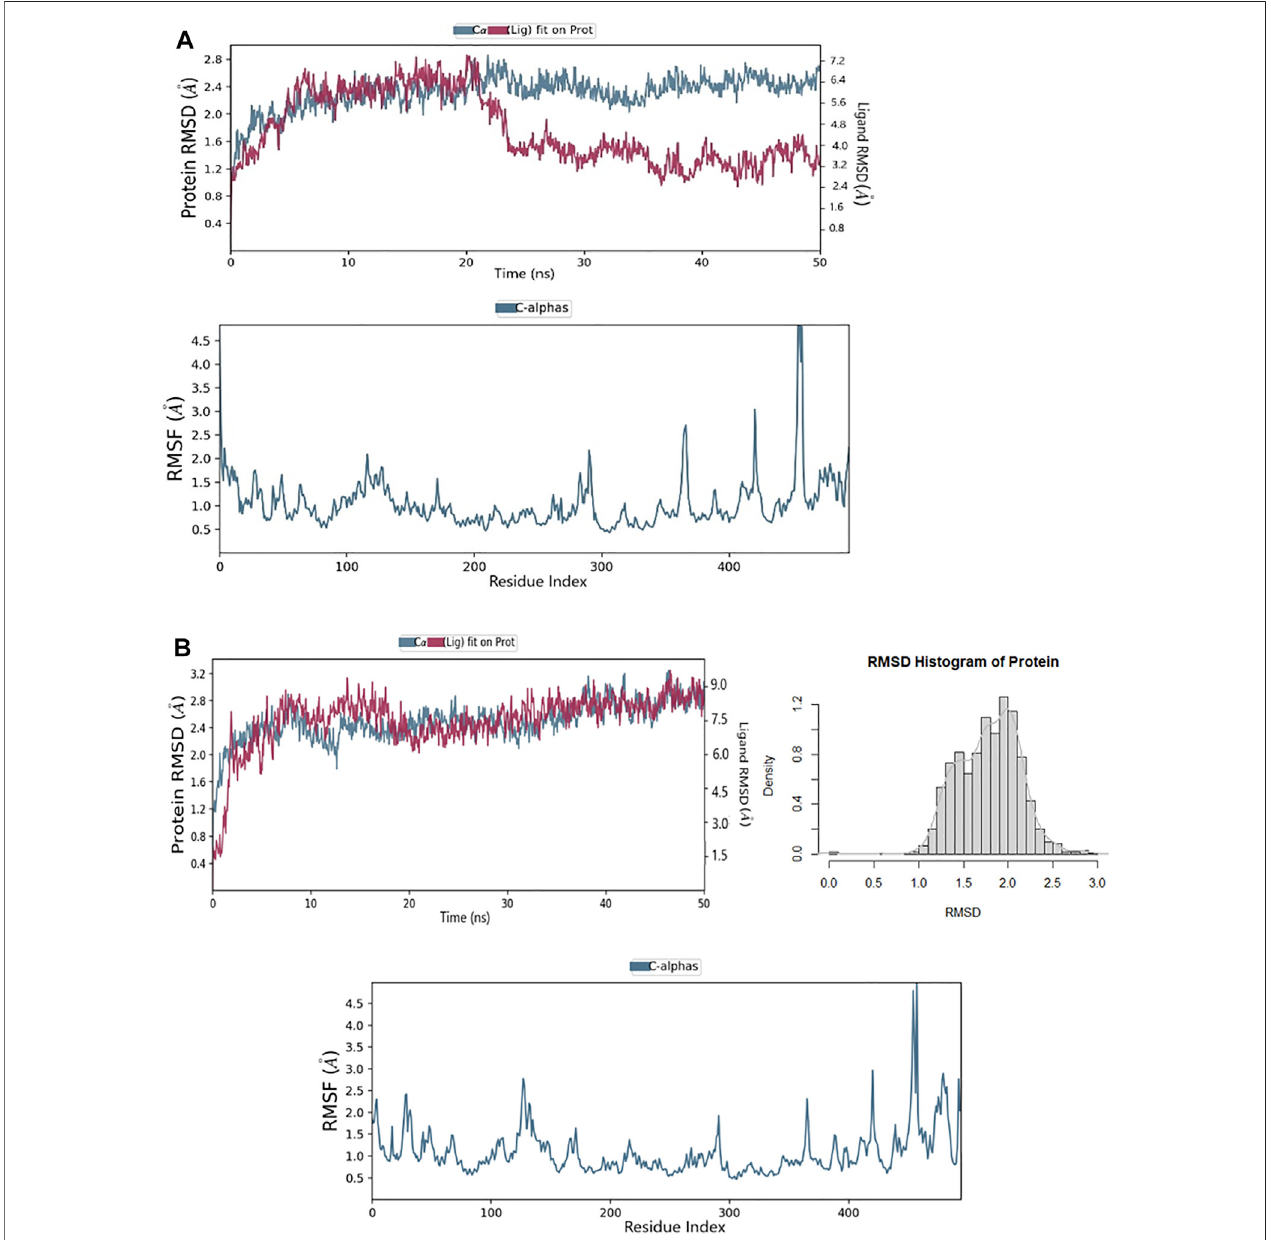
FIGURE 6 | (A) RMSD and RMSF of the PPNDS complex after molecular dynamics (B) RMSD and RMSF of CHEMBL167790 complex after molecular